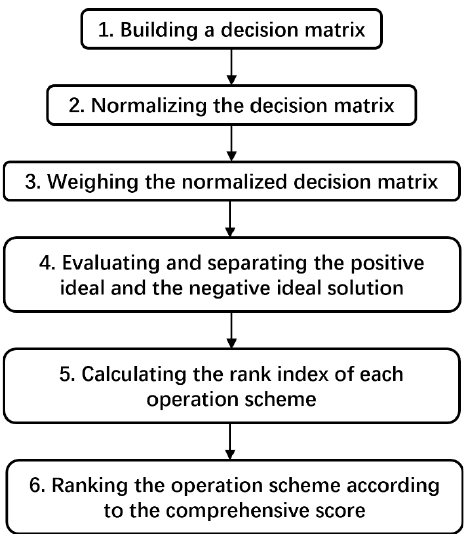
Figure 16. Flow chart of TOPSIS optimization method.